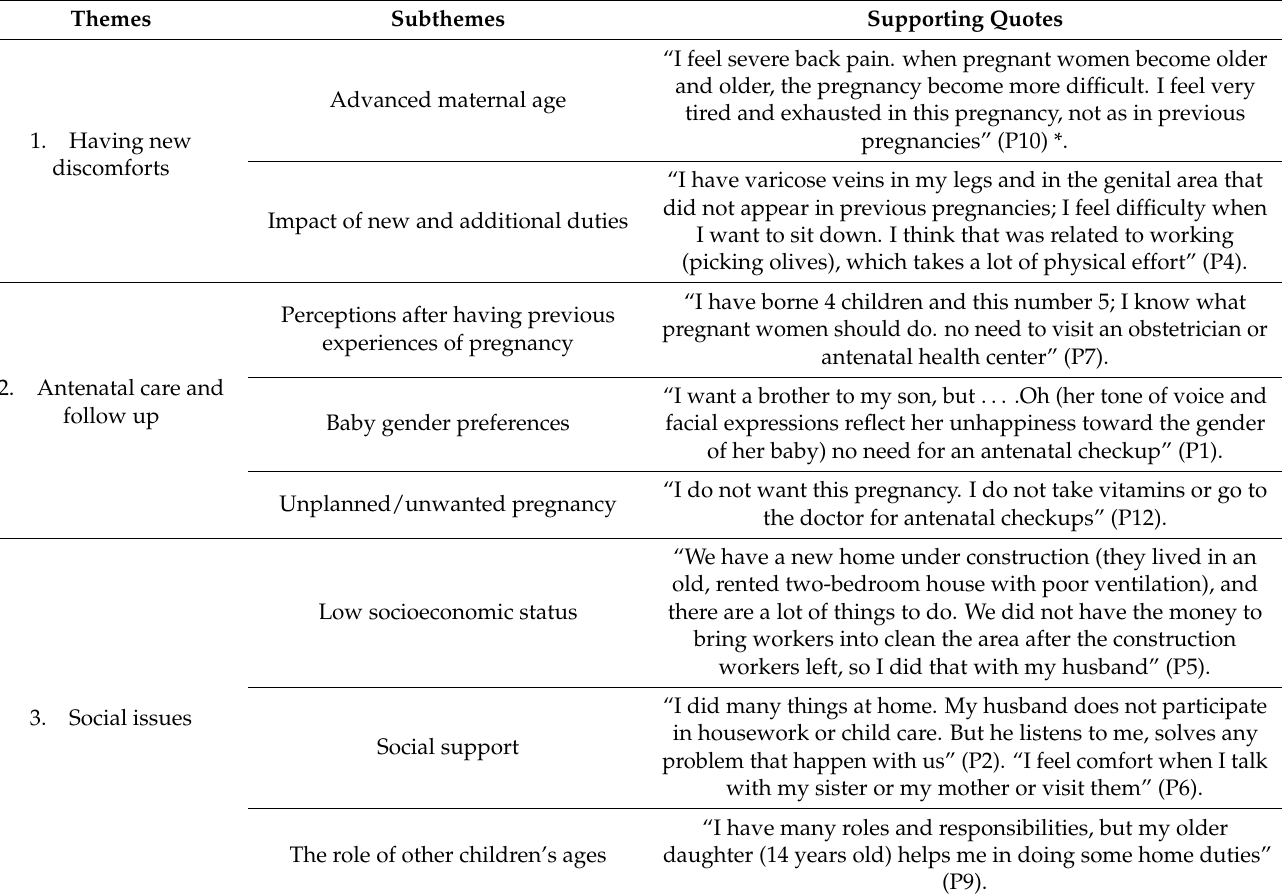
Table 2. Summary of emergent themes and subthemes of participants’